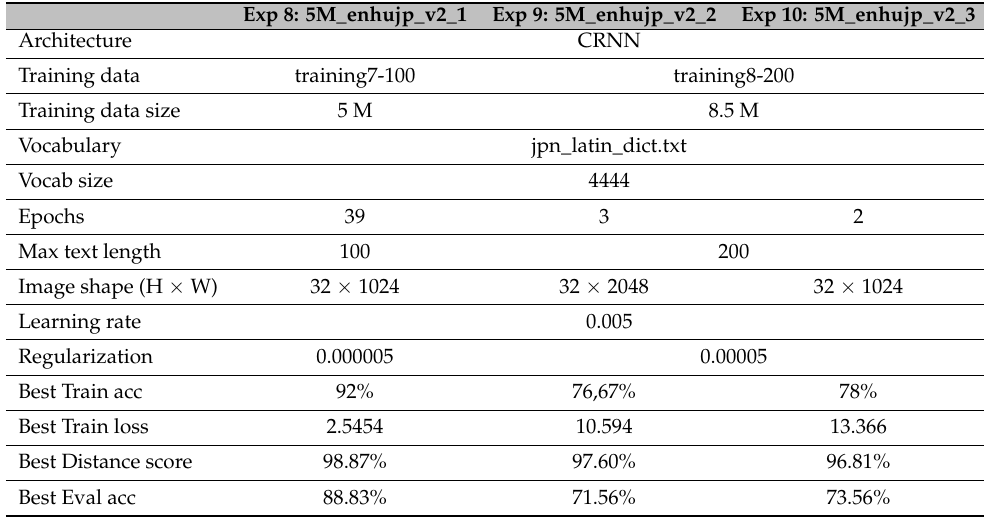
Table 12. Multilanguage Experiments: 8, 9, and